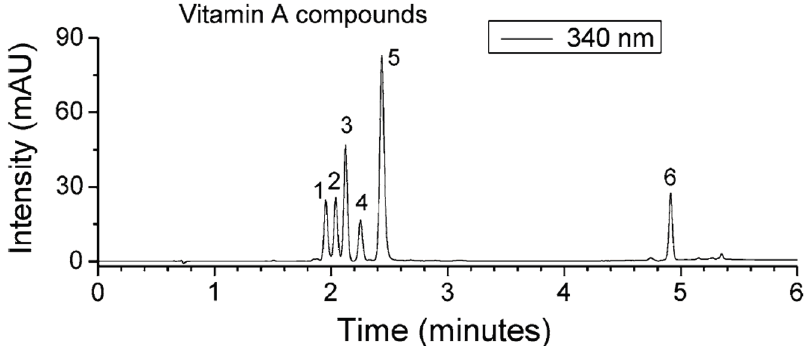
Figure 7. Chromatogram recorded with DPH column, with a gradient of CO 2 /EtOH + formic acid (0.1%) (1.25 mL·min − 1 ), at 55 °C, 1 µL injected at 1 mM, and UV detection